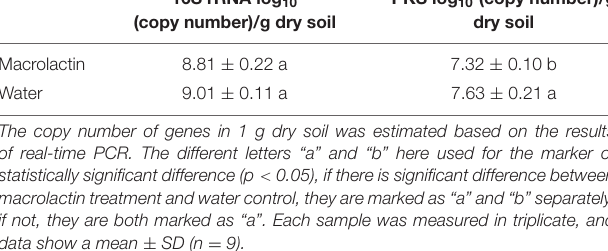
Frontiers in Microbiology |